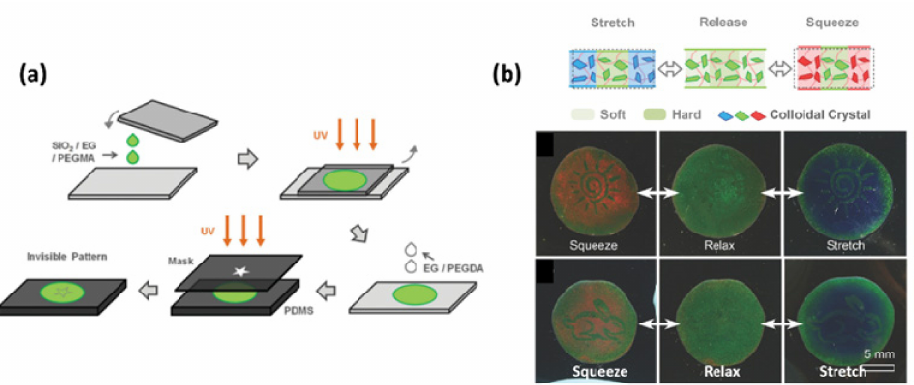
Figure 8. ( a ) Schematic illustration of the preparation process of the invisible colloidal PC pattern shown by deformation. ( b ) Sunlight and rabbit patterns on the photonic prints hidden in a relaxed state and shown by deformation. Reused with permission from Reference [66], Copyright 2014,